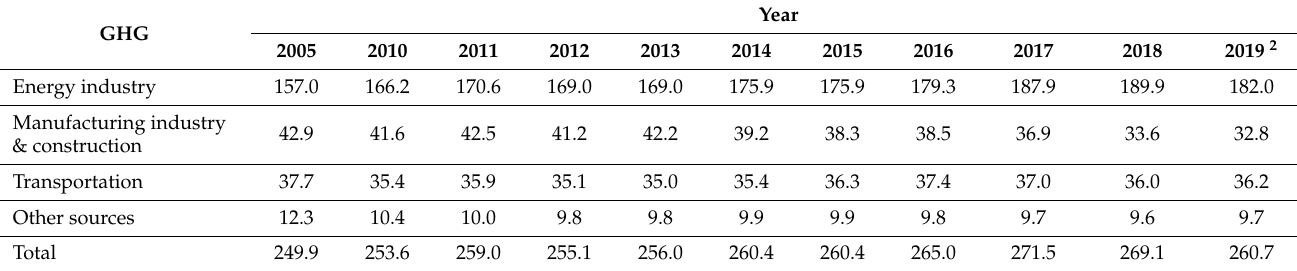
Table 6. Taiwan’s GHG (CO 2 /CH 4 /N 2 O) emissions from various sources in the energy sector since 2005 1 .